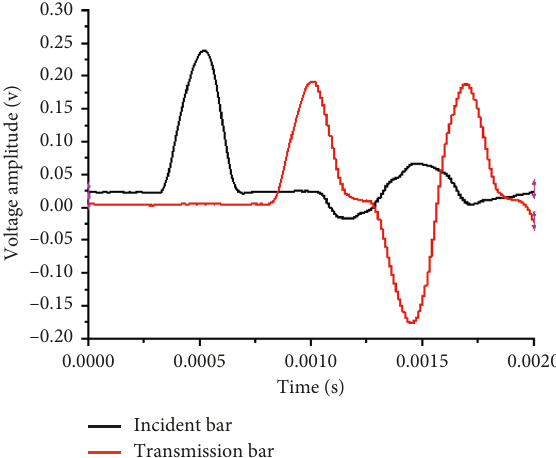
Figure 6: Relationship between dynamic tension strength and loading rate at depth 380m.